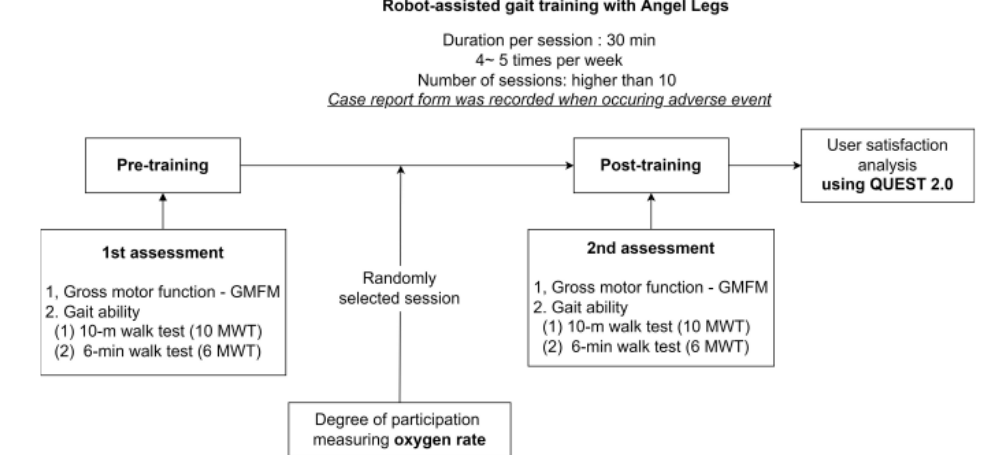
Figure 2. Robot-assisted gait training protocol using the Angel Legs for pediatric patients. GMFM, gross motor function measurement; QUEST 2.0, Quebec User Evaluation of Satisfaction with assistive Technology 2.0.